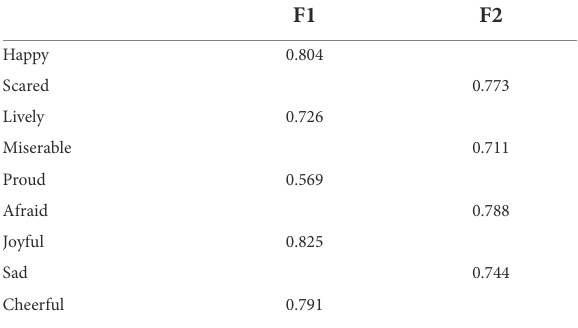
TABLE 2 Rotated component matrix of ST186. TABLE 3 Component matrix of